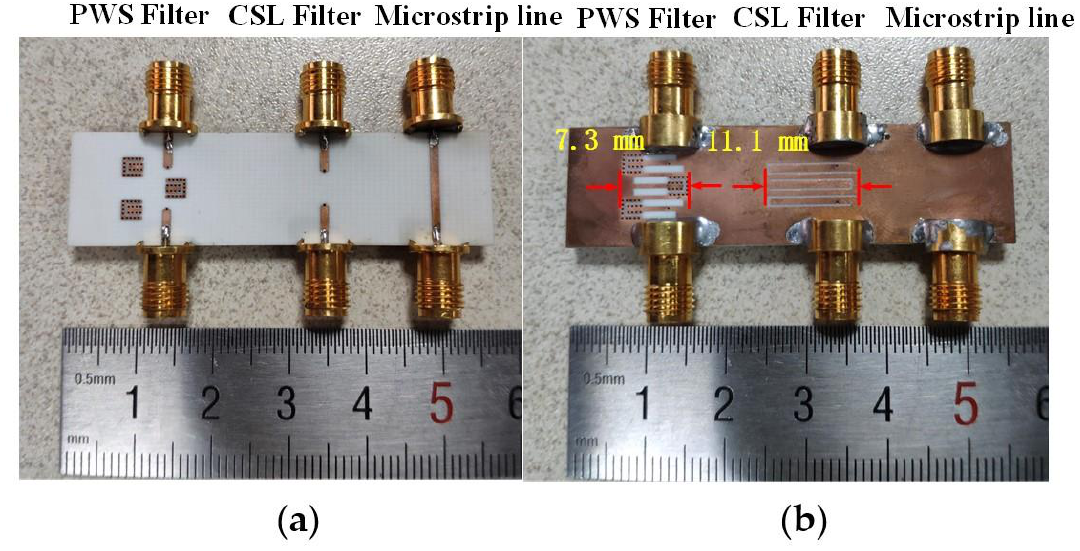
Figure 4. The photo of the proposed BPF. ( a ) the top view of the BPF board, ( b ) the bottom view of the BPF board.